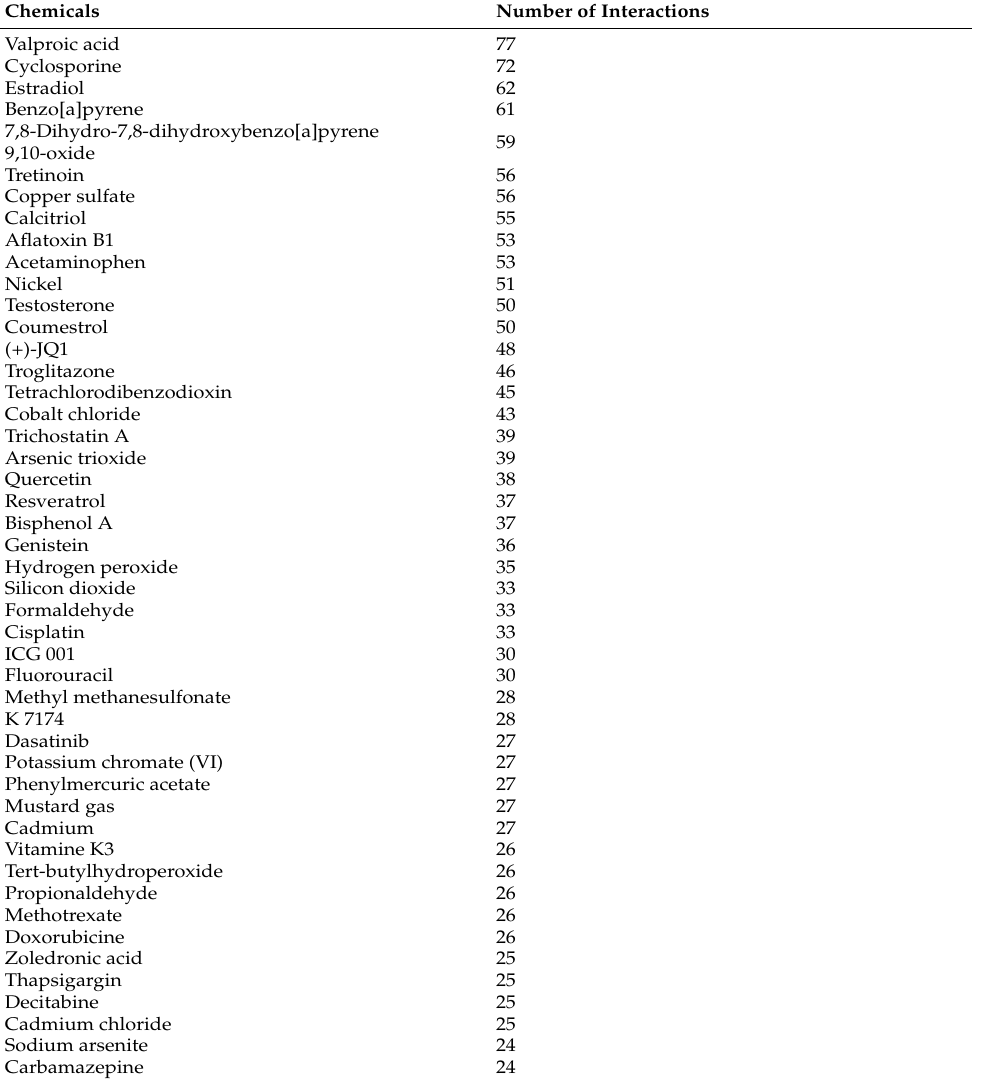
Table 5. Top 50 chemicals interacting with 141 genes differentially activated in breast